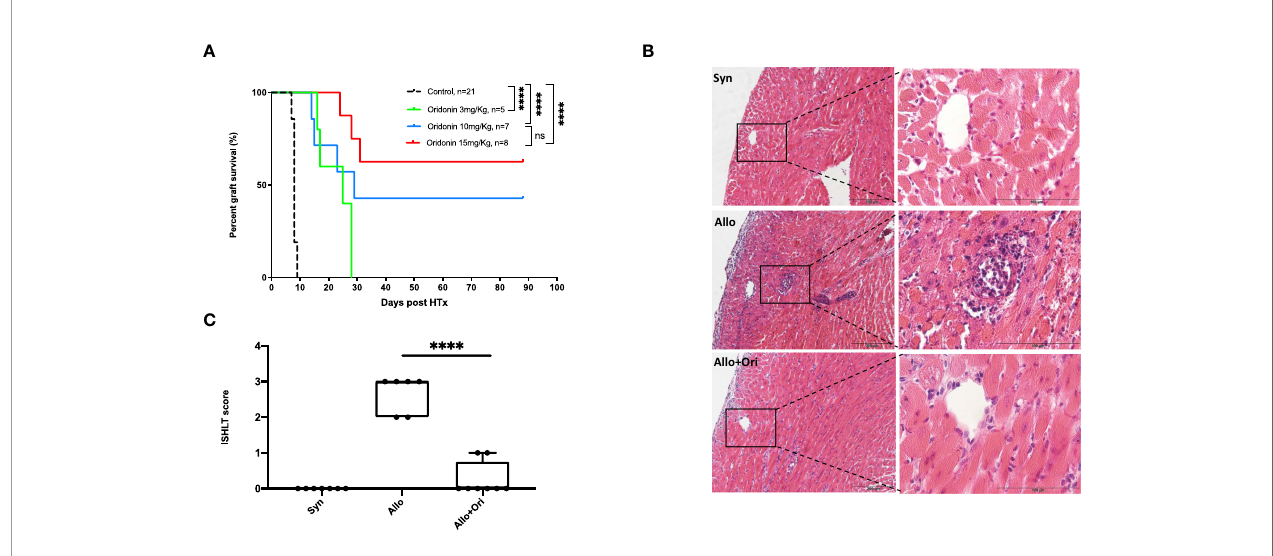
FIGURE 1 | The effect of the Ori on graft survival and pathology in a fully mismatched heart transplantation model. (A) The statistical analysis of graft survival of groups with different dosages of Oridonin and allogeneic control with vehicle. **** p < 0.0001, ns, not signi fi cant. (B) H&E staining of cardiac grafts in syngeneic (Syn), allogenic (Allo), and Ori (Allo + Ori) recipients on POD7. Scale bars represent 100 and 200 µm. (C) According to the standard of ISHLT, evaluate the score of graft rejection among groups. Values are shown as the mean ± SD; **** p < 0.0001; NS, not signi fi